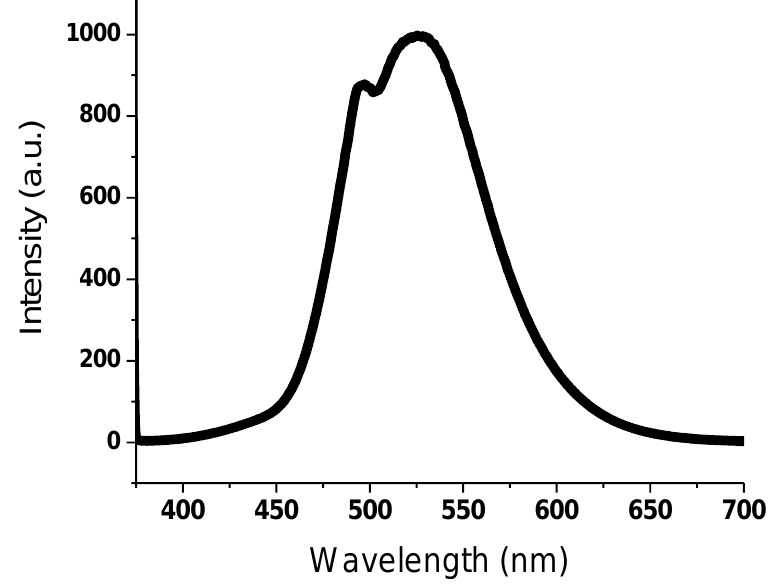
Figure 8. Emission spectra of SAPN@PCP sheets.